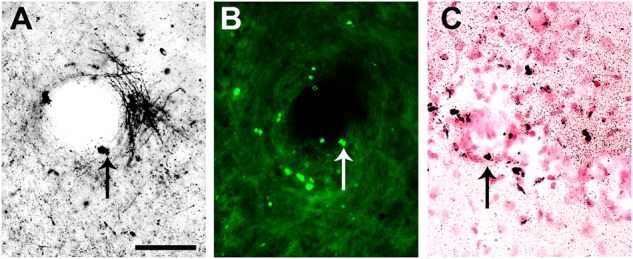
Capillaries in cortical structures bordered by apoptotic-like in a mouse infected with SLEV CbaAr-4005. Capillaries in cortical structures were densely bordered by apoptotic-like neurons, with cell bodies showing nuclear condensation with A-Cu-Ag (A) and Fluoro-Jade B (B) staining. Counterstaining A-Cu-Ag with Nissl confirmed presence of capillaries (C). Bar = 50 μm. This figure is representative of three independent experiments.